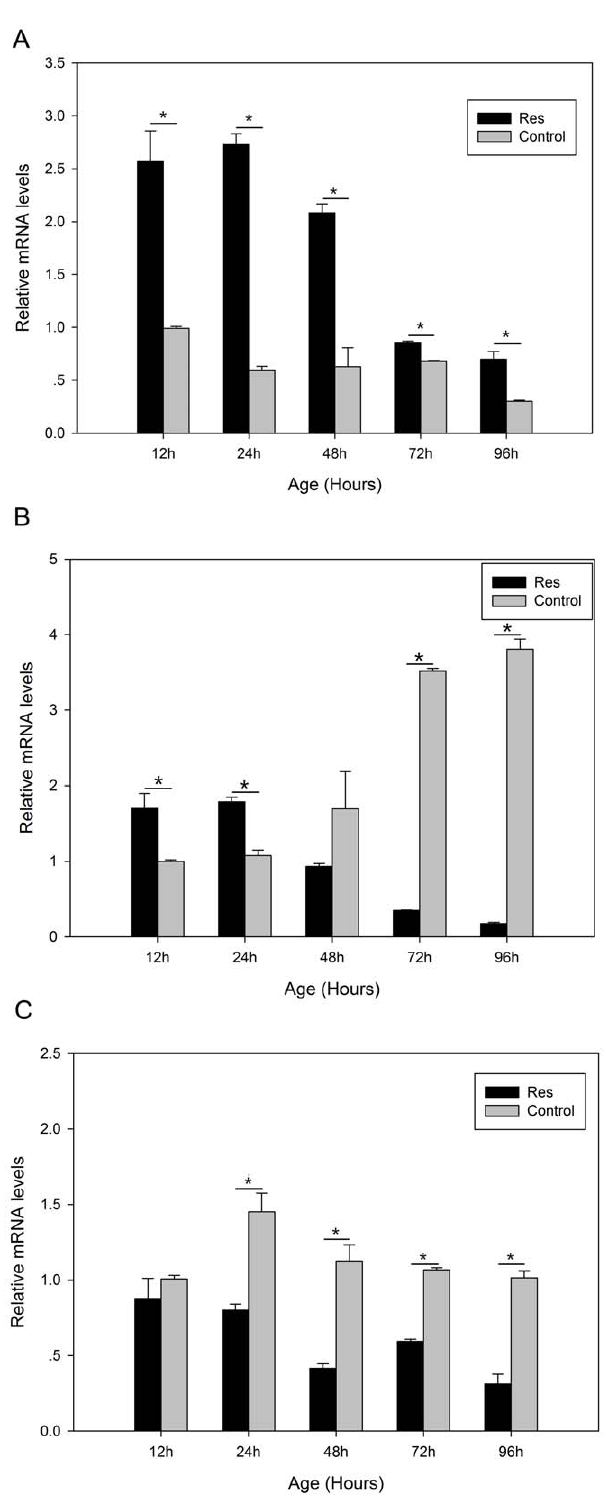
Figure 6. Relative mRNA expression levels of genes encoding the antioxidant enzymes. (a) manganese superoxide dismutase (MnSOD), (b) copper and zinc SOD (CuZnSOD) and (c) catalase (CAT) from B. calyciflorus rotifers treated with resveratrol. The concentration of resveratrol was 5 m M/L. Rotifers cultured in normal medium were used as the control. Each group contained 100 individuals. Bars represent standard errors. The expression levels were statistically analyzed by one- way ANOVA with the Tukey test. ( * P , 0.05).